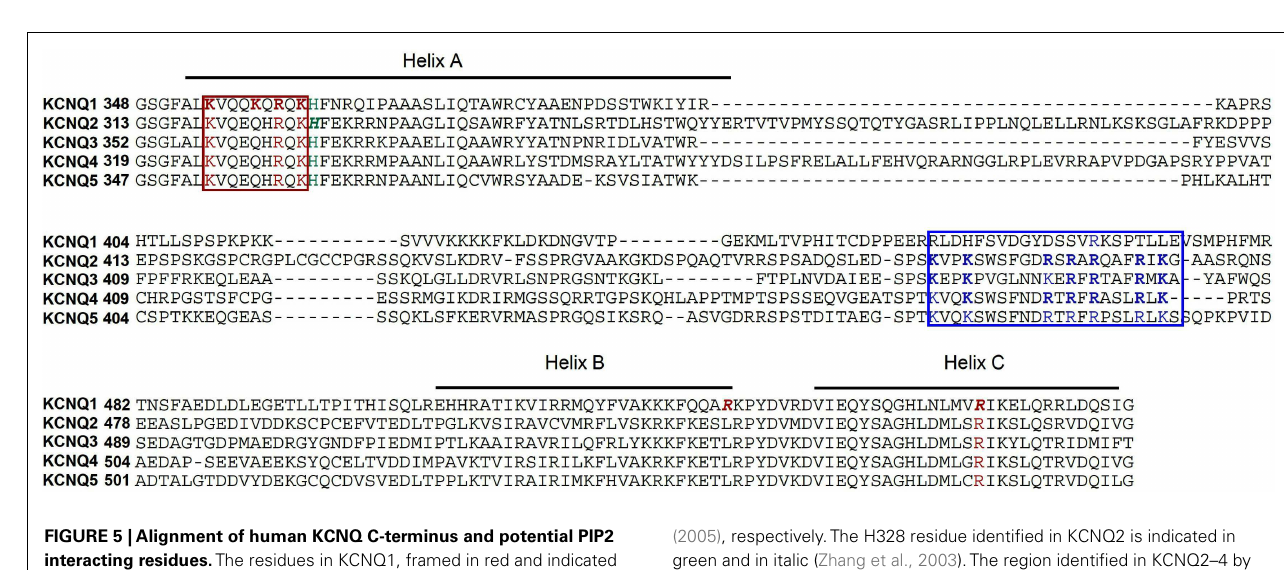
FIGURE 5 |Alignment of human KCNQ C-terminus and potential PIP2 interacting residues. The residues in KCNQ1, framed in red and indicated in red and italic, are those identified byThomas et al. (2011) and Park et al.